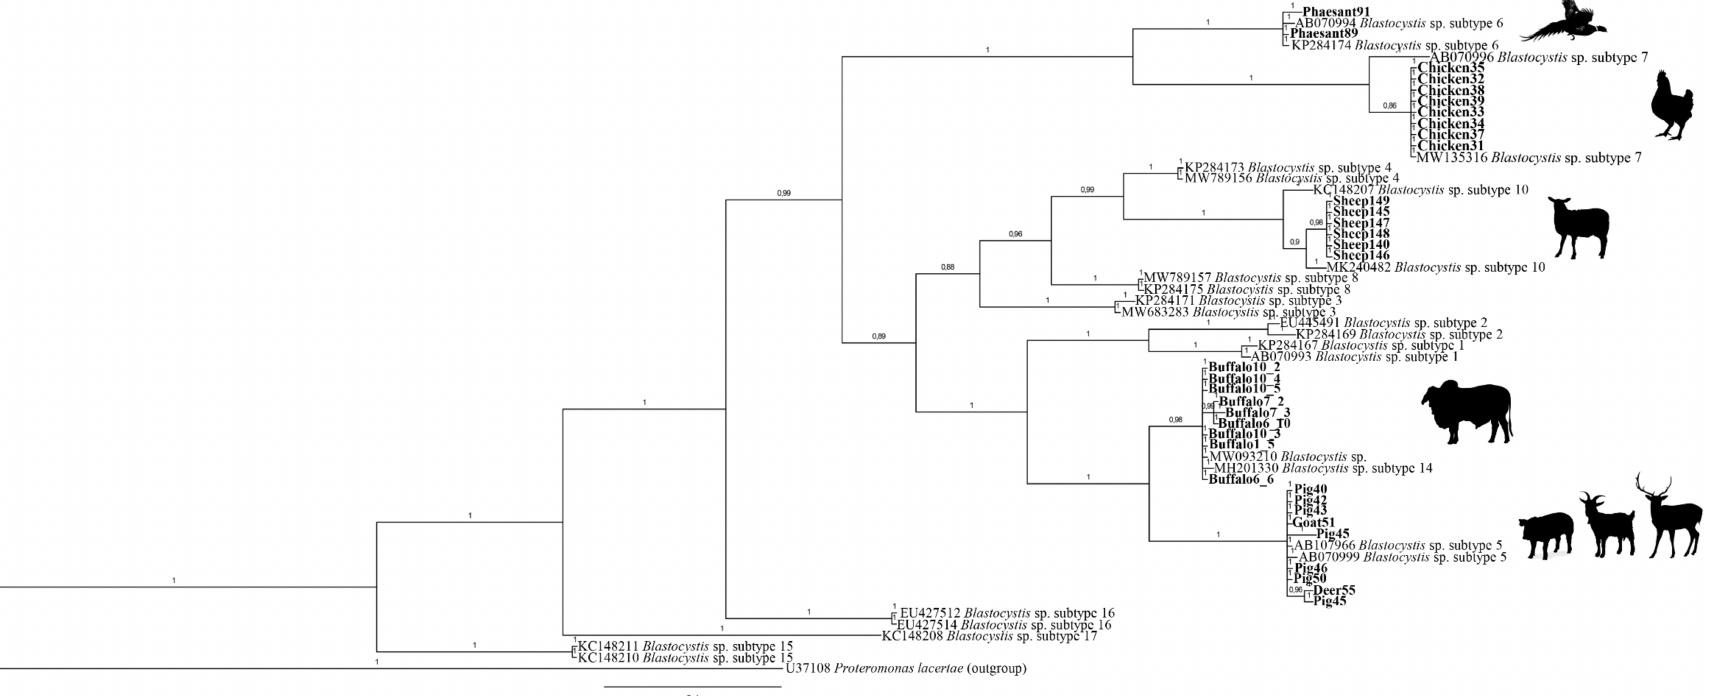
Figure 1. Bayesian inference (BI) obtained from SSU rRNA sequences data set of Blastocystis from animals analyzed in this study, and those from STs previously deposited and available in GenBank™, performed by MrBayes, v. 3.2.7, using the GTR + I + G substitution model. Proteromonas lacertae was used as outgroup. The sequences obtained in this study are given in bold. Taxon labels consist of GenBank number followed by subtype name. Icons indicate where the specimens were